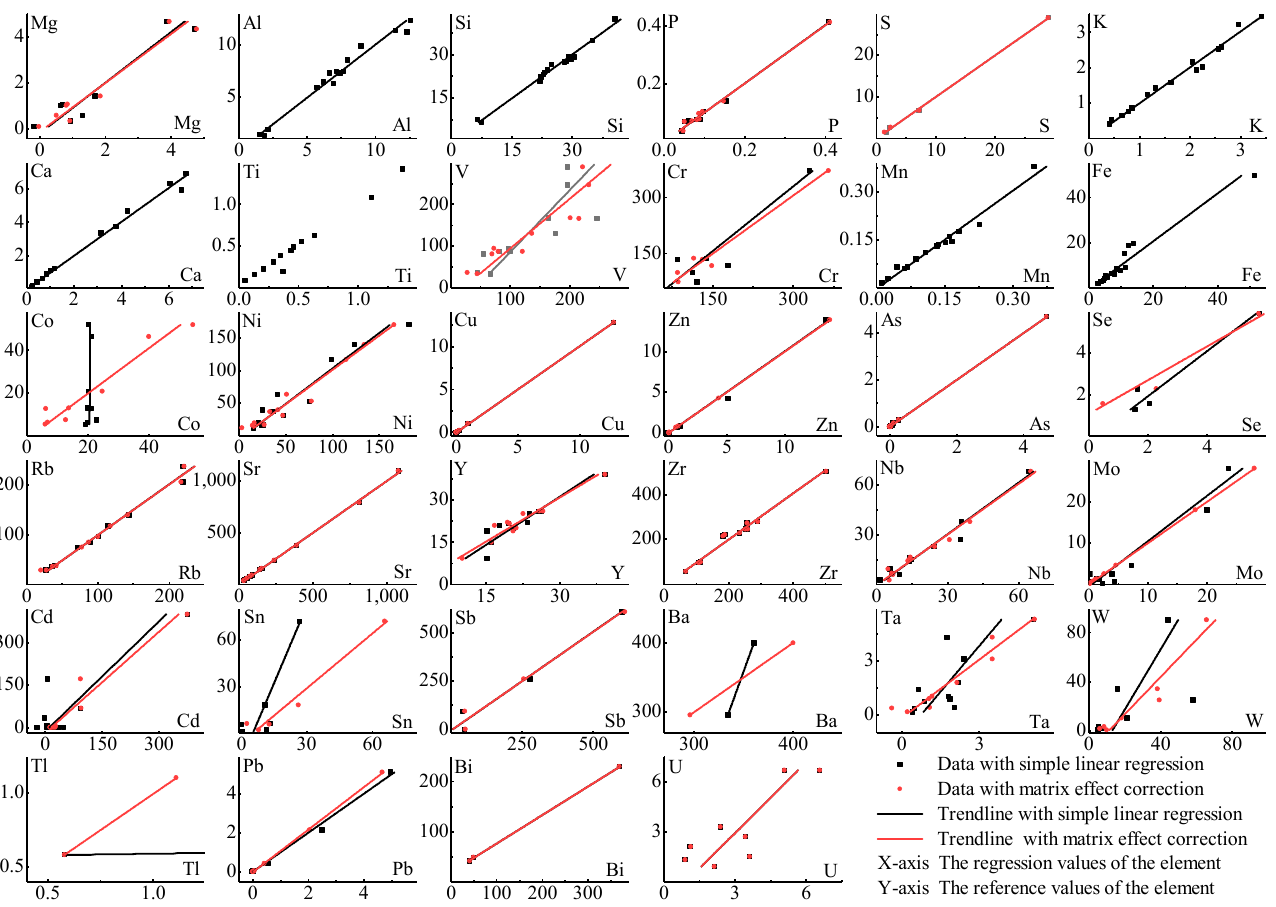
Figure 2. Scatter plots of the new method and the simple linear regression method. The unit is the same as in Figure 1.